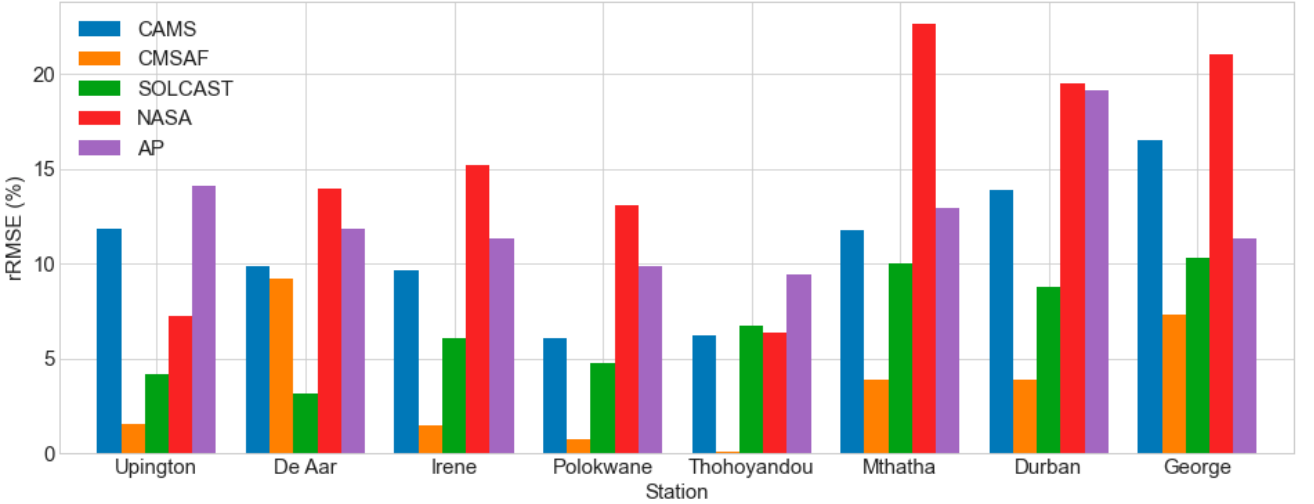
Figure 14. The daily rRMSE of the estimated GHI datasets for overcast sky minus all-sky conditions.